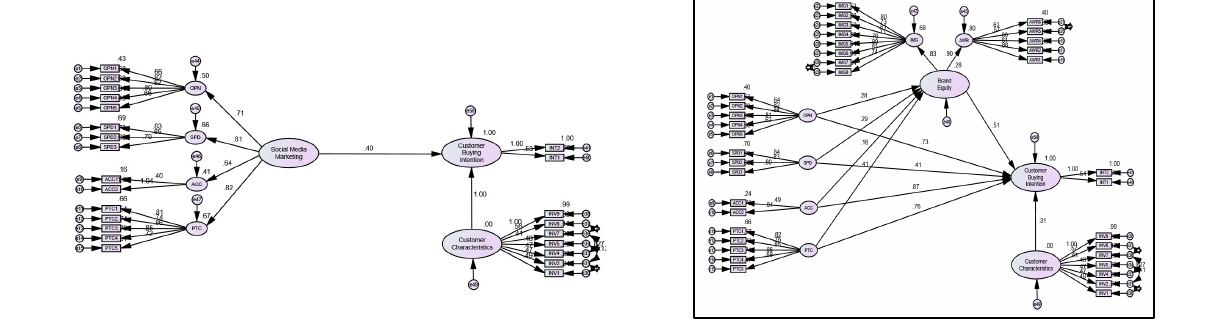
Fig. 4. SEM – Main Model (Model 1) Fig. 5. SEM SMM Sub-Hypothesis Model (Model